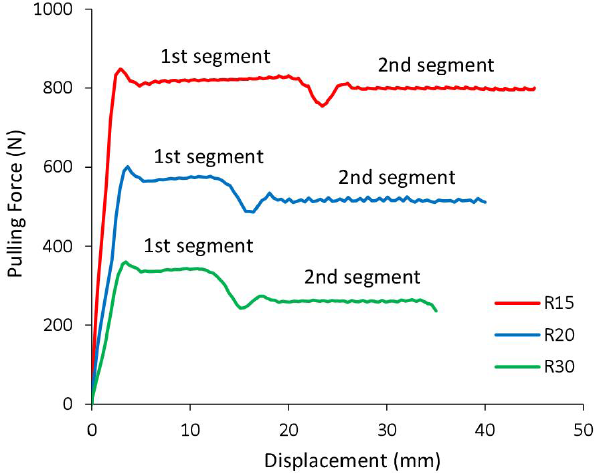
Table 4. Friction